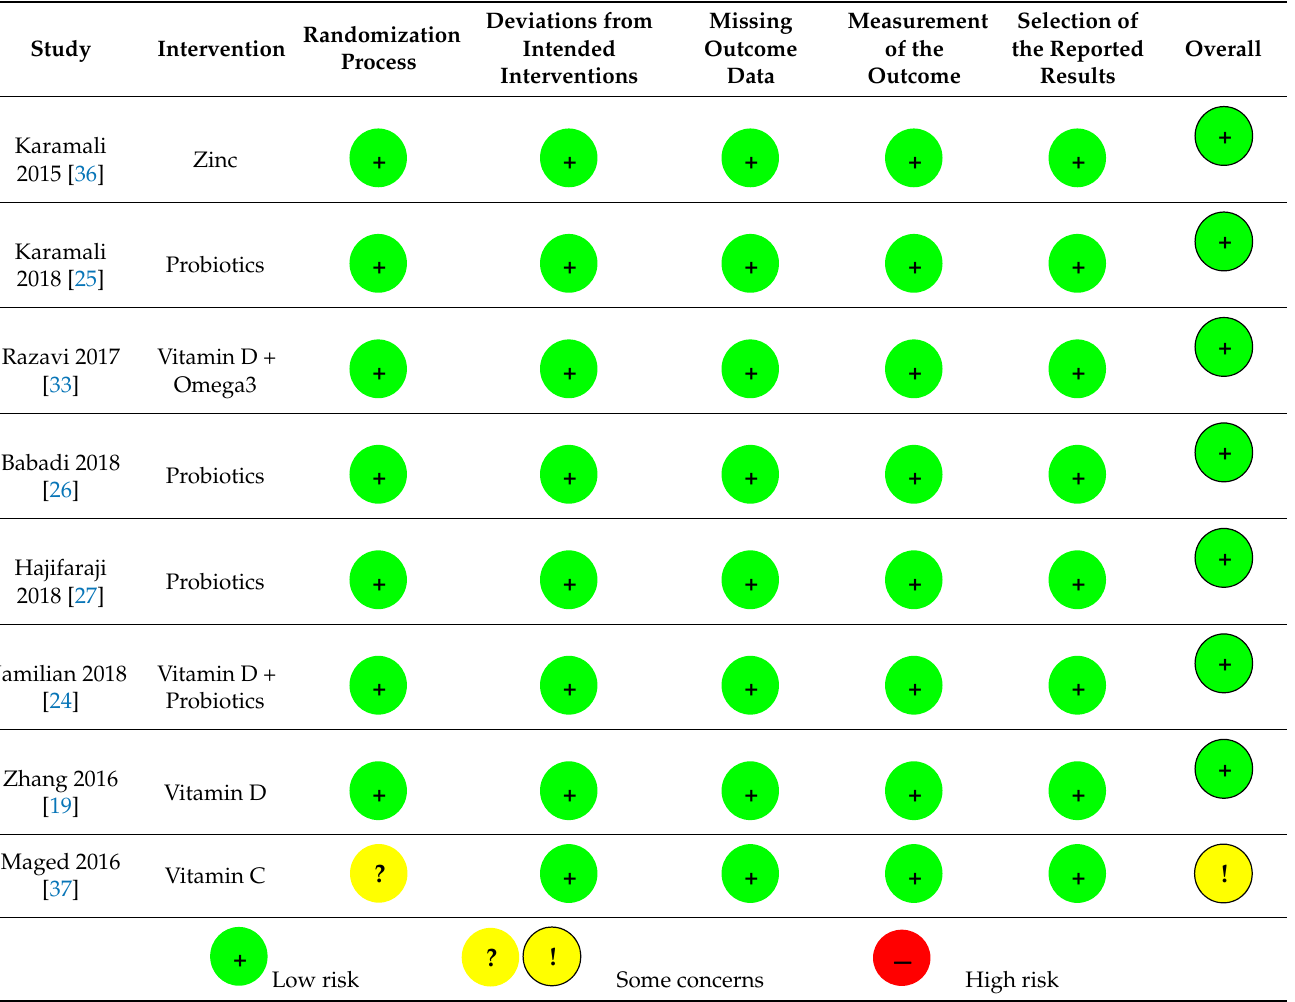
Table 2. Risk of bias of selected studies.